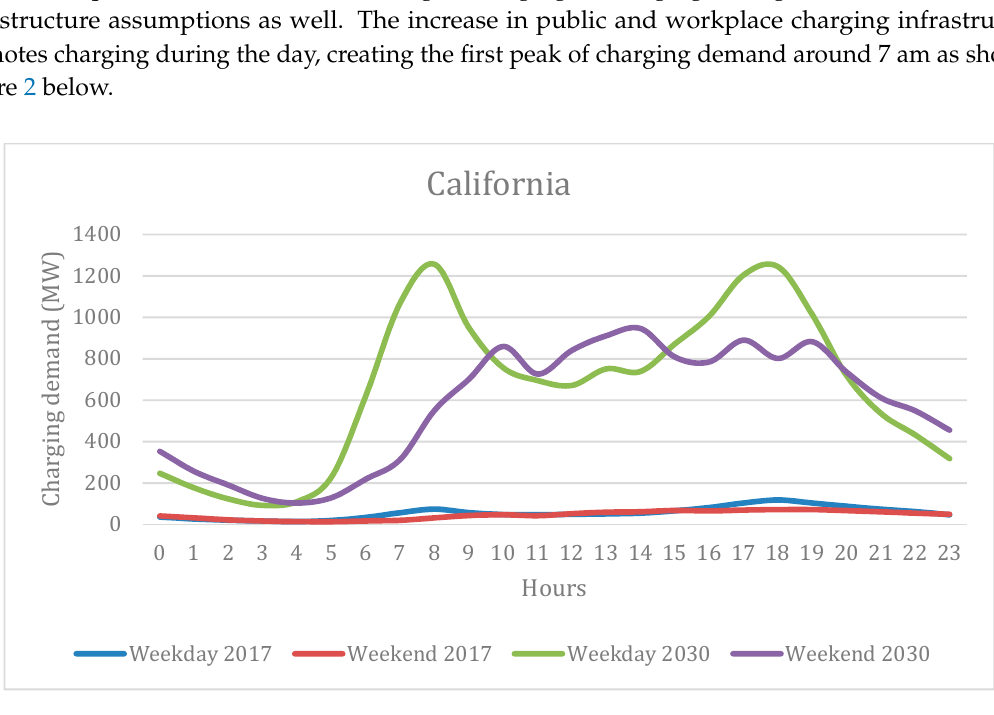
Figure 2. Unmanaged Charging Demands in California—2017 and 2030—Mid Scenario